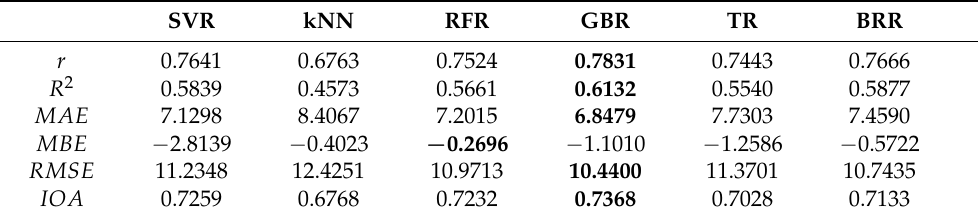
Table 3. Performance of machine learning models. Bold values indicate the best performance. SVR kNN RFR GBR TR BRR r 0.7641 0.6763